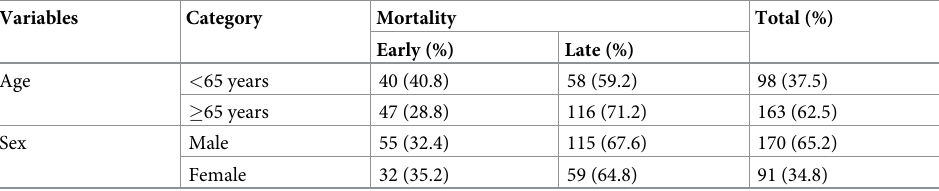
Table 1. Socio-demographic characteristics between early mortality and late mortality among COVID-19 patients at Addis Ababa COVID-19 care centers, Ethiopia, 2022 (n = 261).